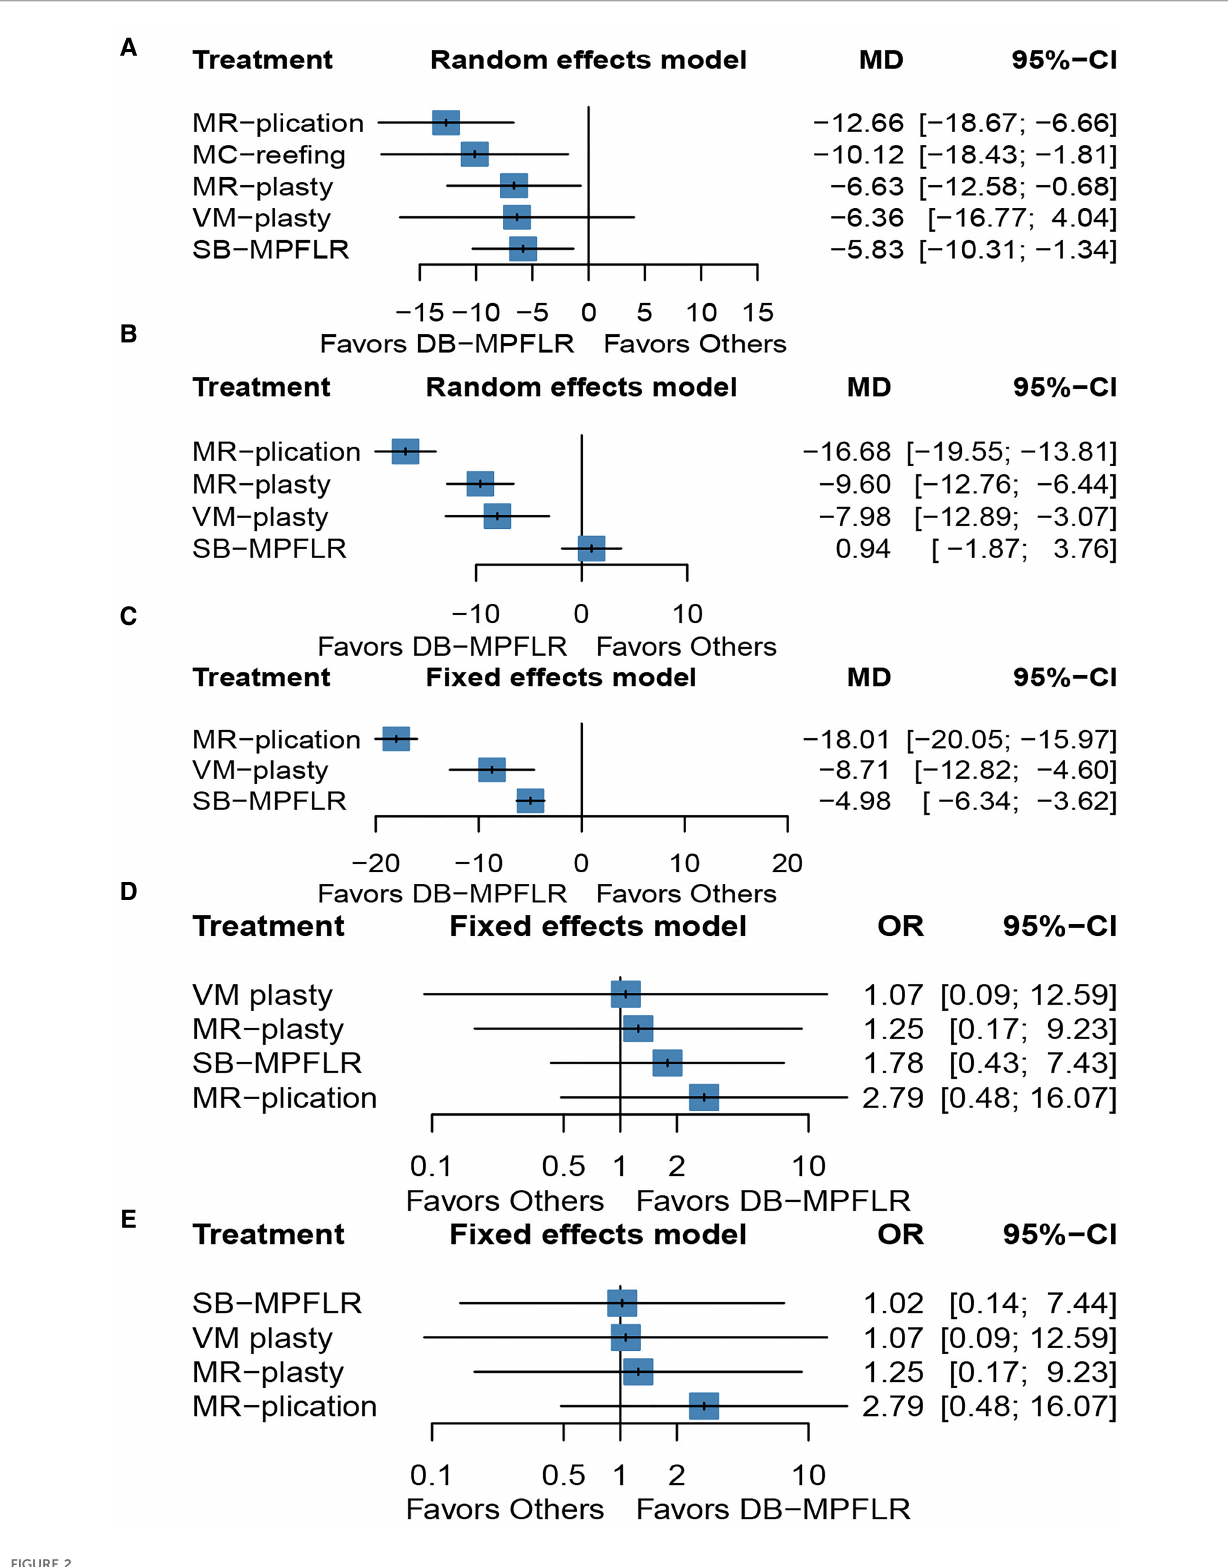
FIGURE 2 Forest plot of different surgeries: ( A ) kujala score; ( B ) lysholm score; ( C ) IKDC score; ( D ): redislocation; ( E ) recurrent